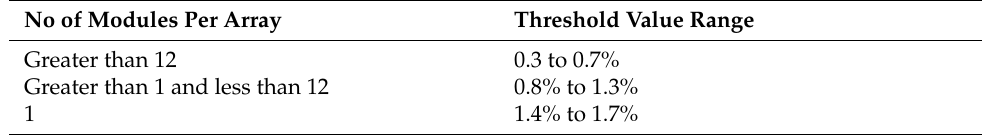
Table 1. Threshold Value